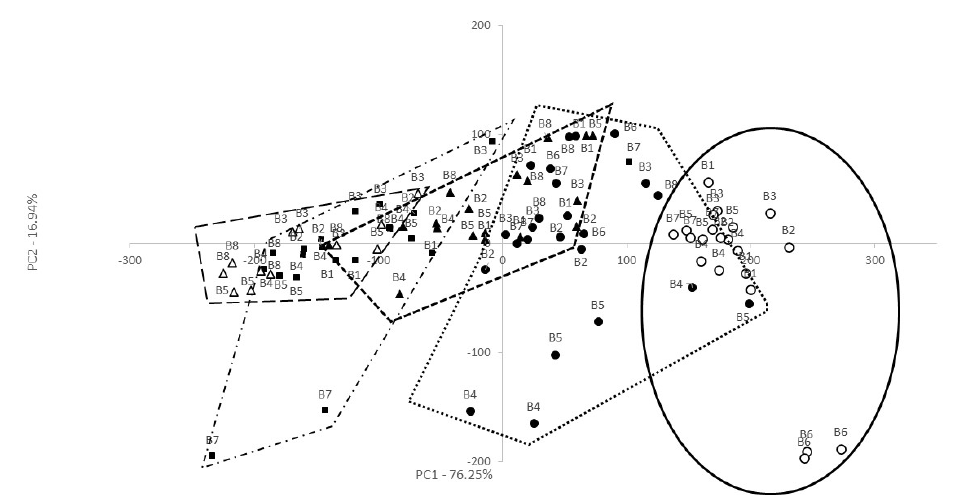
Figure 1. Projection of “bryndza” cheese from 8 producers (B1–8) onto the space defined by the first two principal components (PC1 / PC2) based on the e-nose results. Sample groups according to the month: ○ —May, ● —June, ▲ —July, ■ —August, ∆ —September.